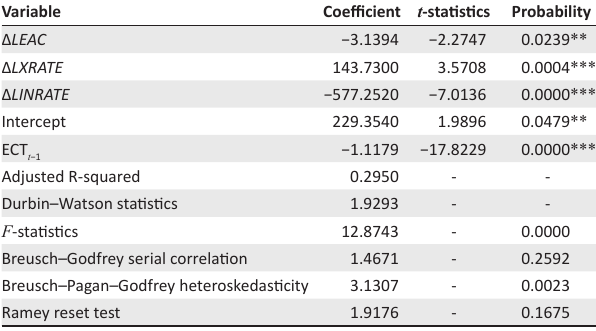
TABLE 2: Unit root test. Log level ADF (with trend and intercept) PP (with trend and intercept)